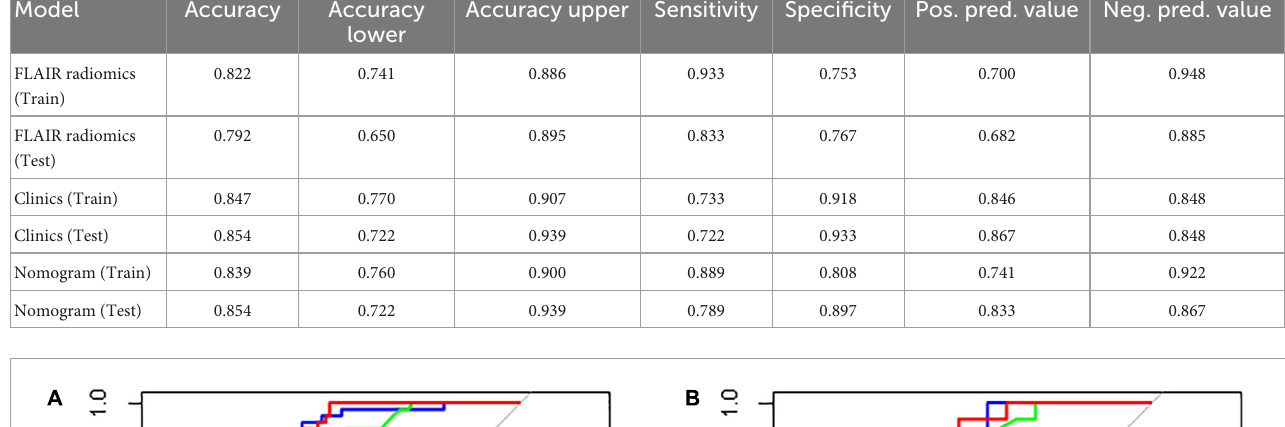
TABLE 5 The prediction results of the three models in the training and test sets.